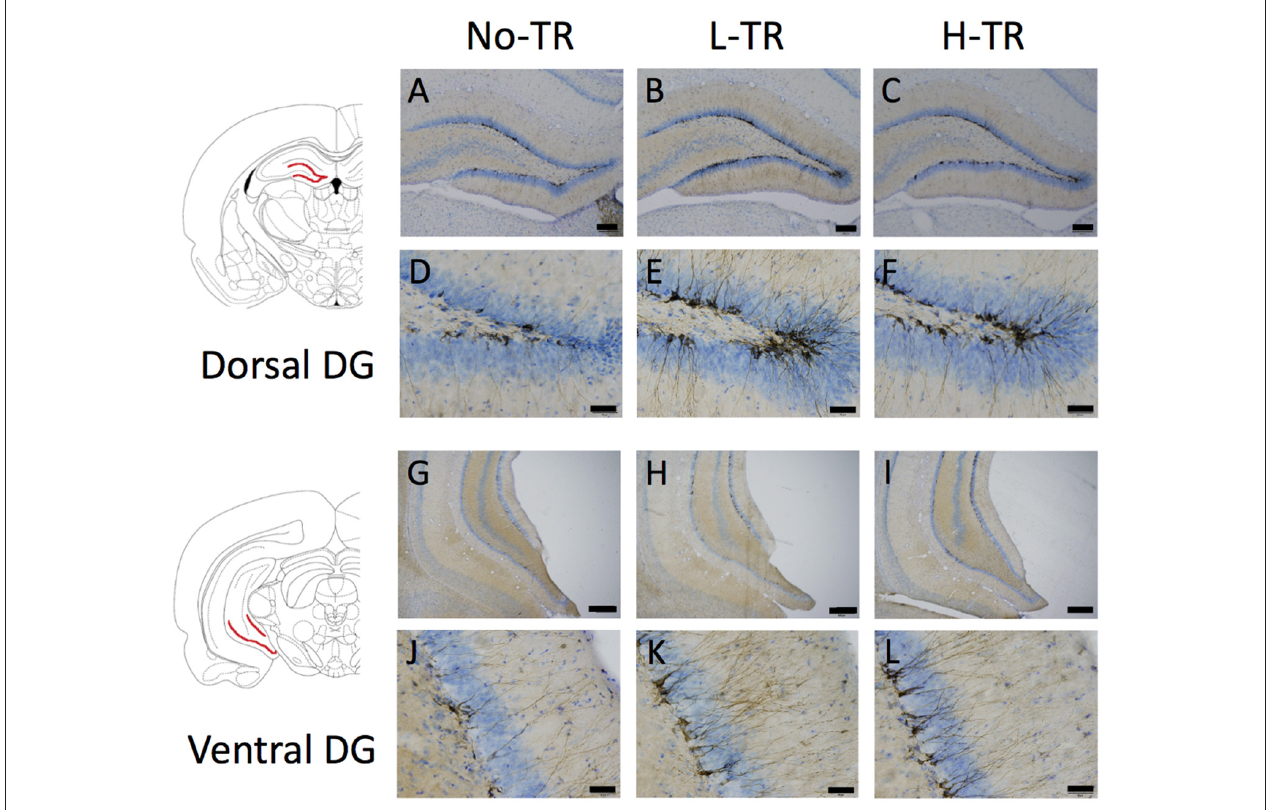
FIGURE 5 | Photographs of sections immunostained for doublecortin (DCX) in the dorsal (A–F) and ventral (G–L) hippocampal dentate gyrus (DG) of rats that performed regular treadmill running at different intensities (No-TR, sedentary; L-TR, low intensity; H-TR, high intensity). High-power photomicrograph of the dorsal DG (D–F) and the ventral DG (J–L) . Scale bars are 200 µ m (A–C,G–I) and 50 µ m (D–F,J–L) .